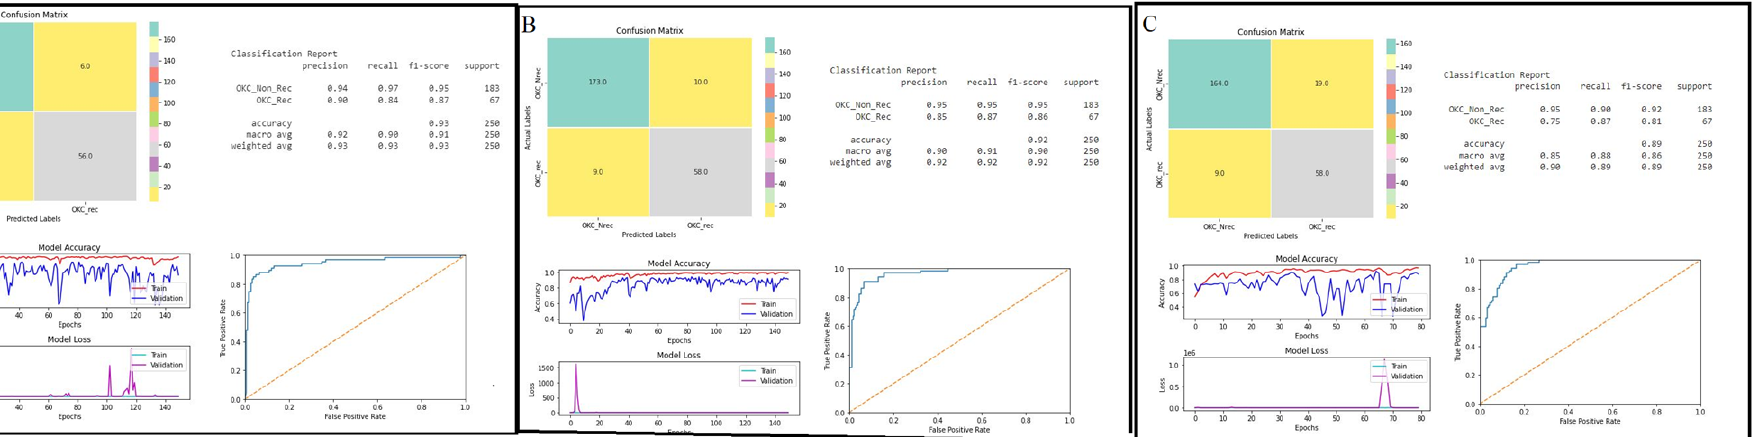
Figure 4. Performances of the deep-learning classifiers: ( A ) DenseNet-121, ( B ) Inception-ResNet-V2, and ( C ) Inception-V3 were demonstrated using confusion matrix, classification report for accuracy, area under ROC curve, model accuracy (accuracy vs. epochs), and loss (loss vs. epochs)